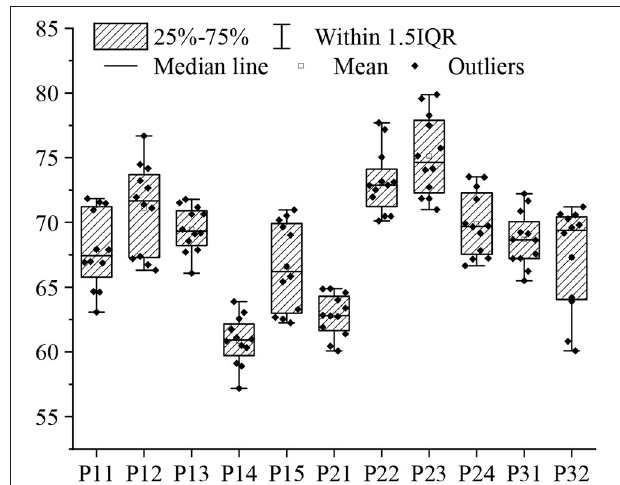
FIGURE 8 | Scoring results of the smart tourism platform based on tourism